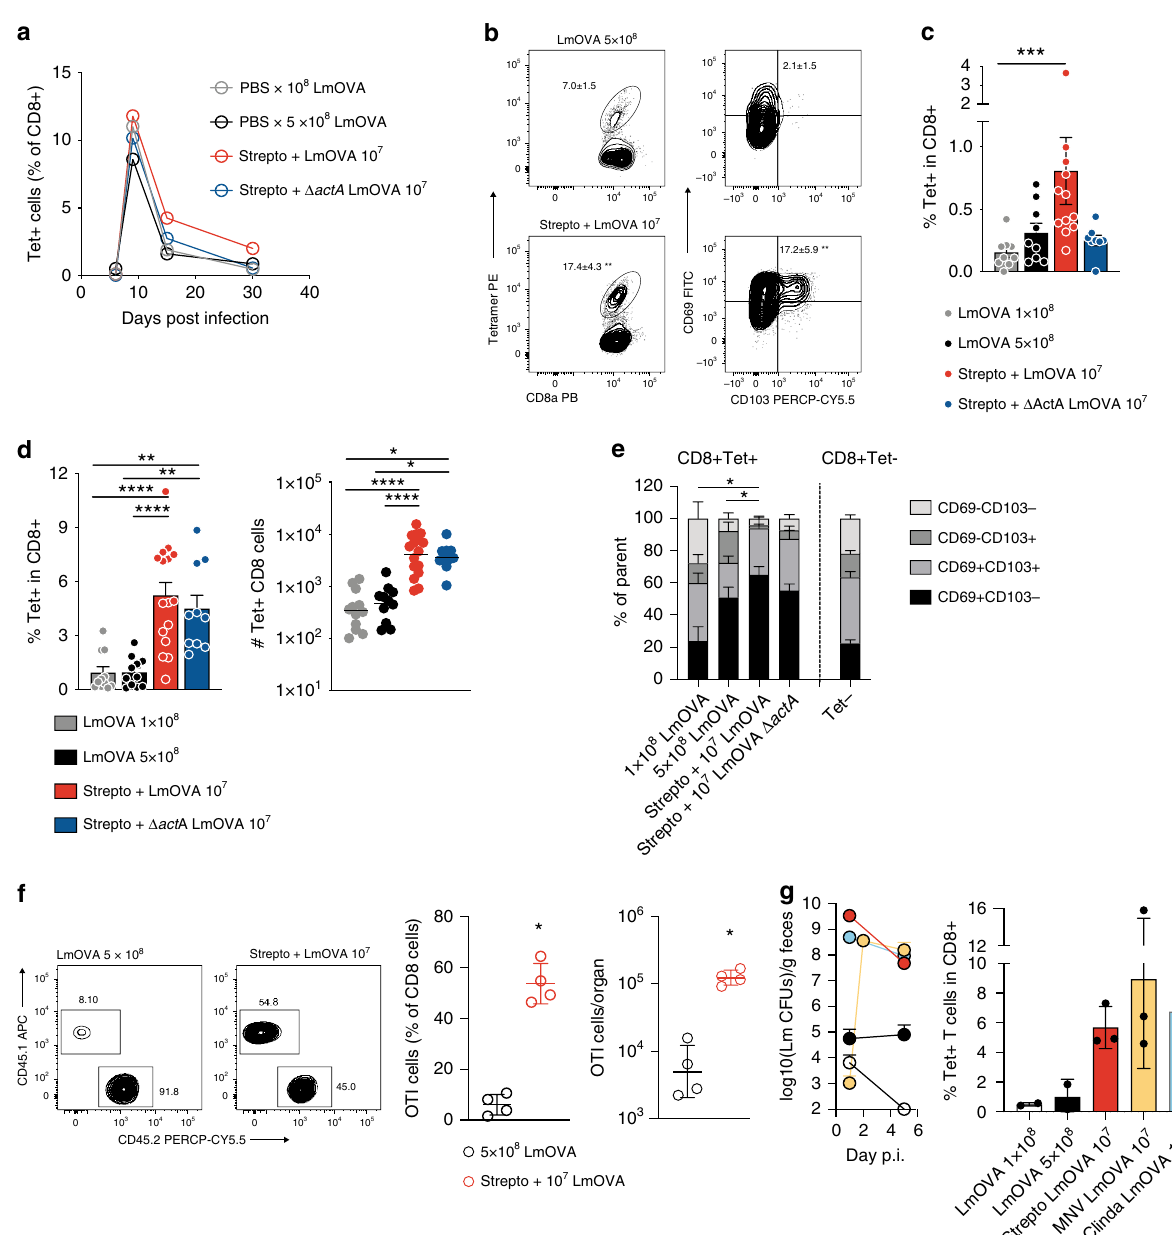
Fig. 2 Transient microbiota depletion enhances accumulation of antigen-speci fi c CD8 + Trm in the intestine. a Kinetics of expansion and contraction of SIINFEKL-speci fi c T cells in the blood of immunized animals, as assessed by tetramer staining ( n = 3, one representative of at least 2 experiments per group; shown are means; see also Supplementary Figure 3 for cumulative data). b Representative FACS plots showing percentages and phenotype of tetramer- positive T cells in the large intestine lamina propria at d9 following immunization with the depicted strategies ( n = 6, data pooled from 2